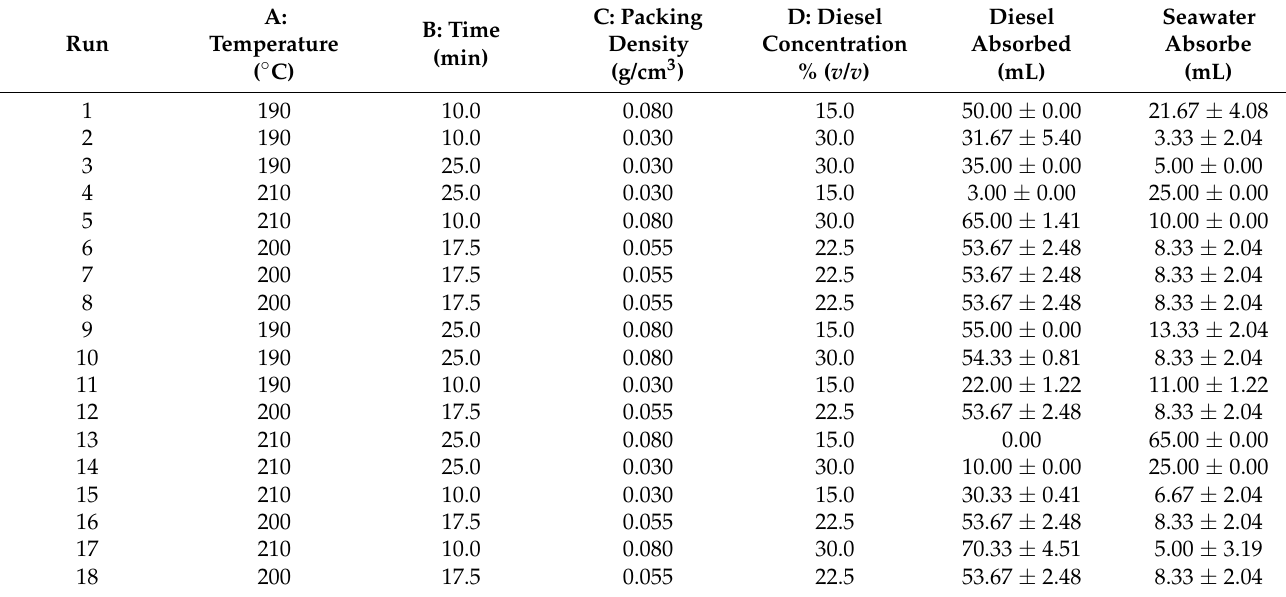
Table 1. Secondary screening of significant parameters for diesel–seawater sorption by CP using Plackett–Burman design (±SEM, n = 3).